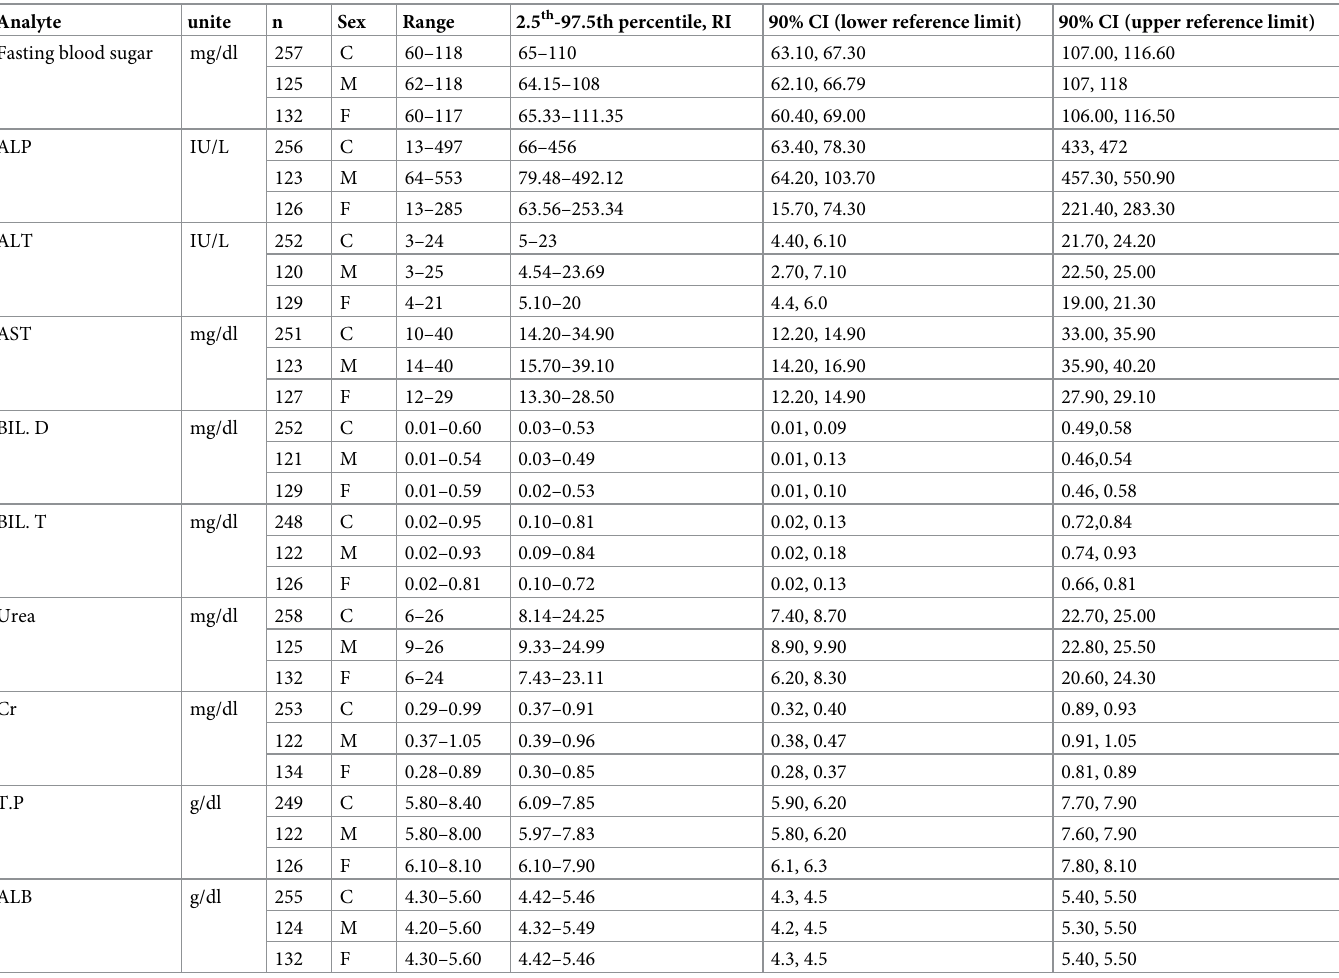
Table 3. The 90% CI for the lower and upper reference limits of clinical chemistry parameters for adolescents in Mekelle, Tigrai, North Ethiopia, 2019.